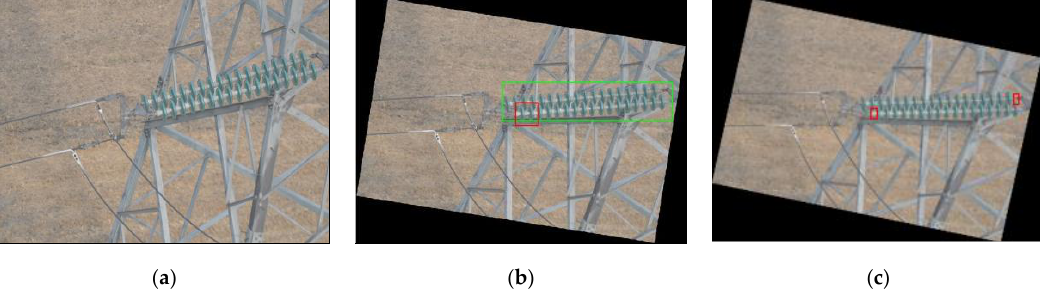
Figure 12. Detection result of self-shattering located at the end of insulator string: (a) Original image; (b) Literature [23] method; (c) Proposed method.